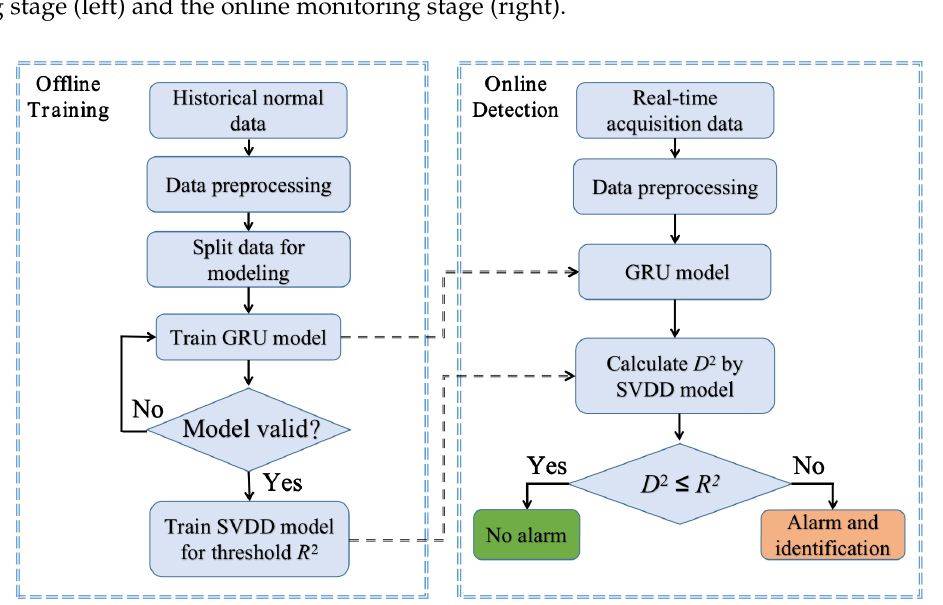
Figure 4. Flowchart of the GRU-support vector data description (SVDD)-based fault detection and identification